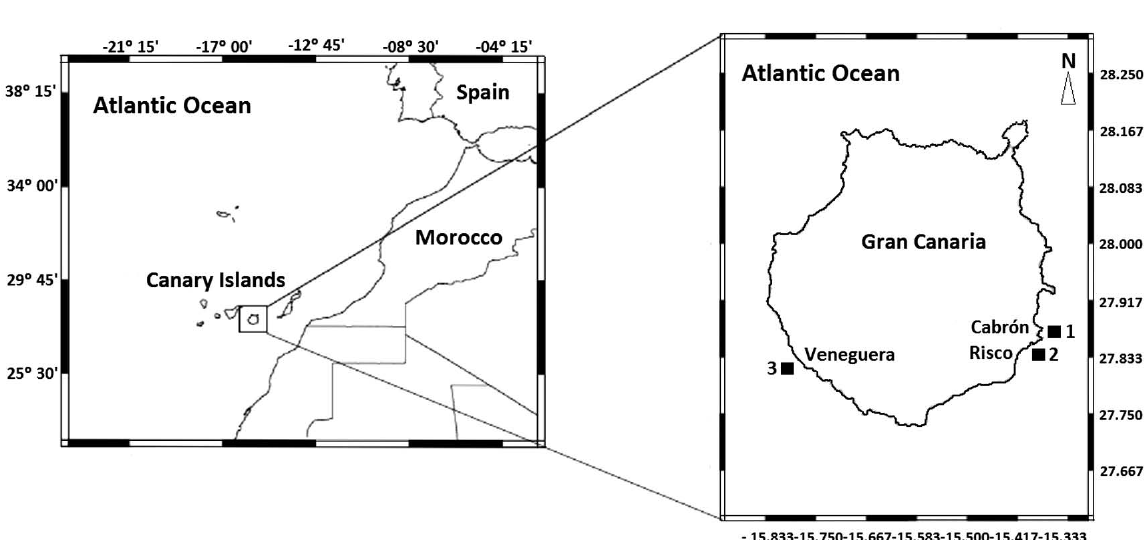
Fig. 1. – Map of the Canary Islands (northeastern Atlantic Ocean) showing the position of Gran Canaria Island and the three studied locations.